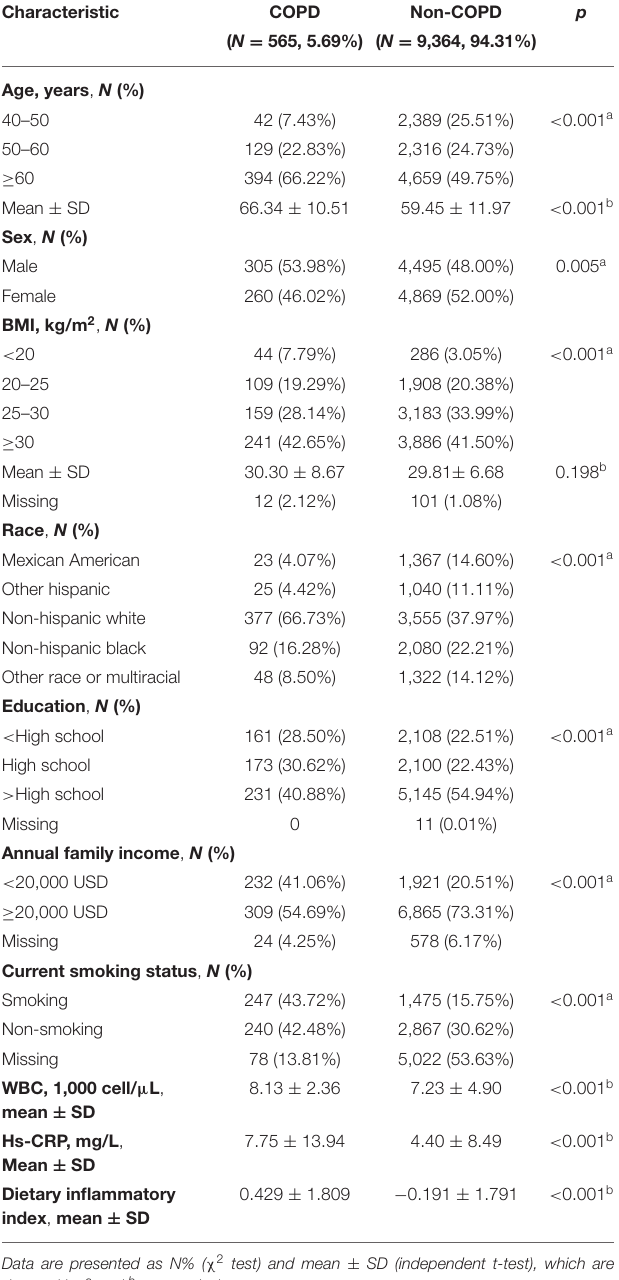
TABLE 1 | Demographics and characteristics of participants from NHANES